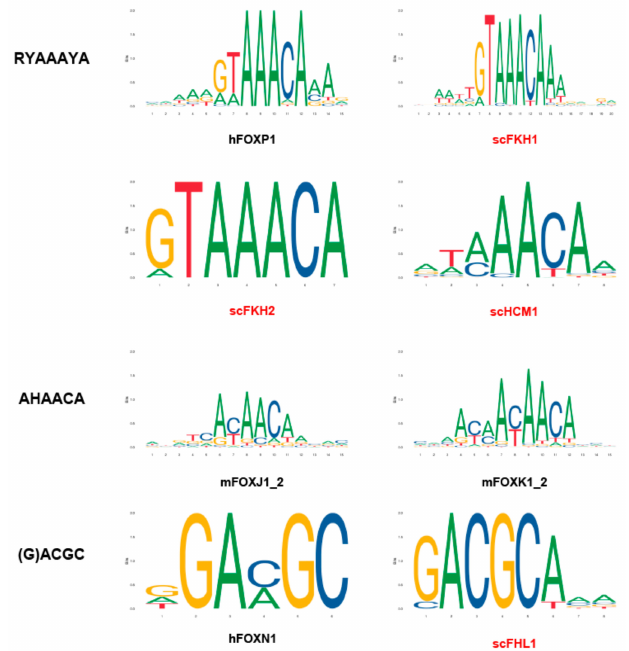
Figure 2. The DNA motifs preferentially bound by Fox TFs. TF binding profiles are obtained through JASPAR, an open-access database (http: // jaspar.genereg.net) {Fornes, 2020